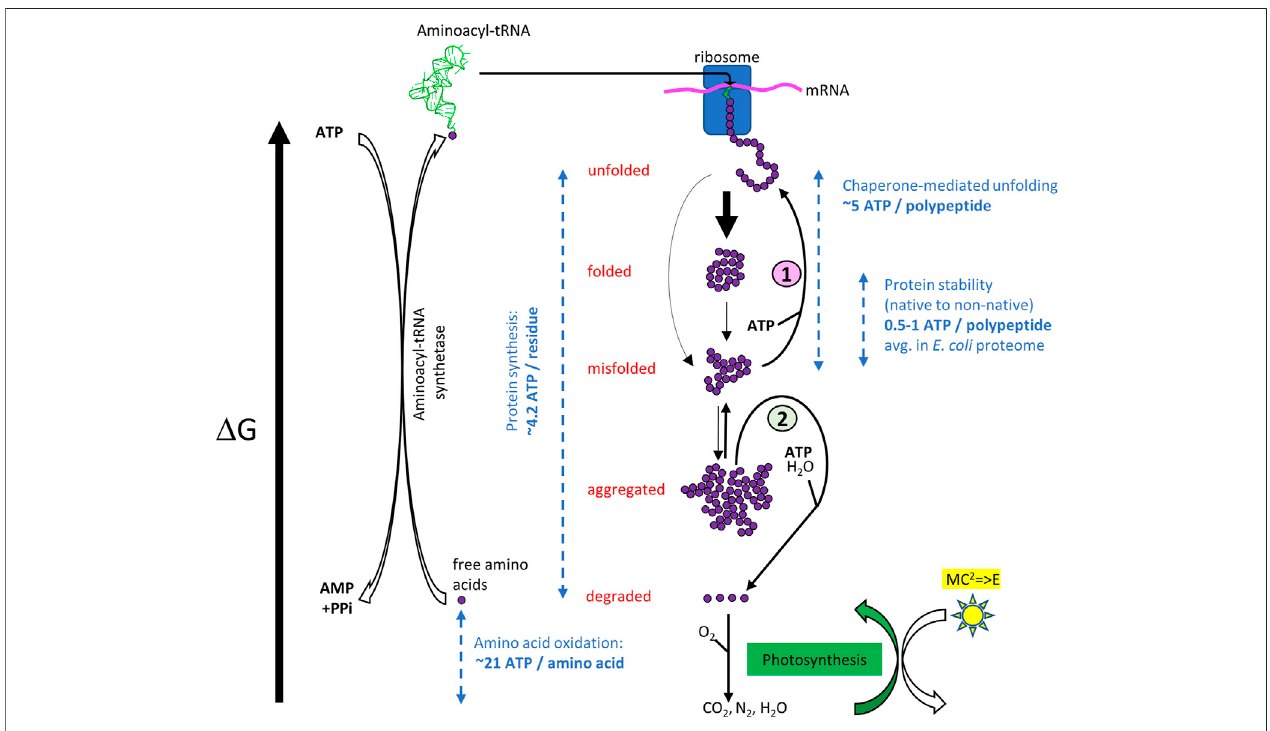
FIGURE 1 | ATP-cost of the open, non-equilibrium free energy cycle of cellular protein homeostasis. Top. When forming in the ribosome, a nascent polypeptide is unfolded, and it has the highest free energy. It may then spontaneously collapse into the native state (folded) or reach metastable misfolded states (misfolded). Heat stress can reduce the kinetic barriers between states. Even without heat stress, the native state can partially unfold and convert into a misfolded state, which in turn converts into stable non-native oligomers (aggregated). (1) The misfolded and aggregated species can be structurally “ repaired ” into native species again by ATP- fueledunfoldingchaperones,or(2)bedegradedbyproteases gatedbyATP-fueledunfoldingchaperones(Rothmanand Kornberg,1986).Freeaminoacidsmay further degradeintomorestableinorganicmoleculesfromwhichnewaminoacidscanbesynthetized,usingenergyinitiallyoriginatingfromthesun,intheformofATPgenerated by photosynthesis. ATP-consuming aminoacyl-tRNA synthetases may then load free amino acids with the highest free energy state, which in the ribosomes can spontaneously form less energetic peptide bonds into an unfolded polymer with a lower free energy. Dashed blue arrows indicate typical energy differences between various states, expressed as ATP equivalents (Jungas et al., 1992; Ghosh and Dill, 2010; Sharma et al., 2010; Kaleta et al.,